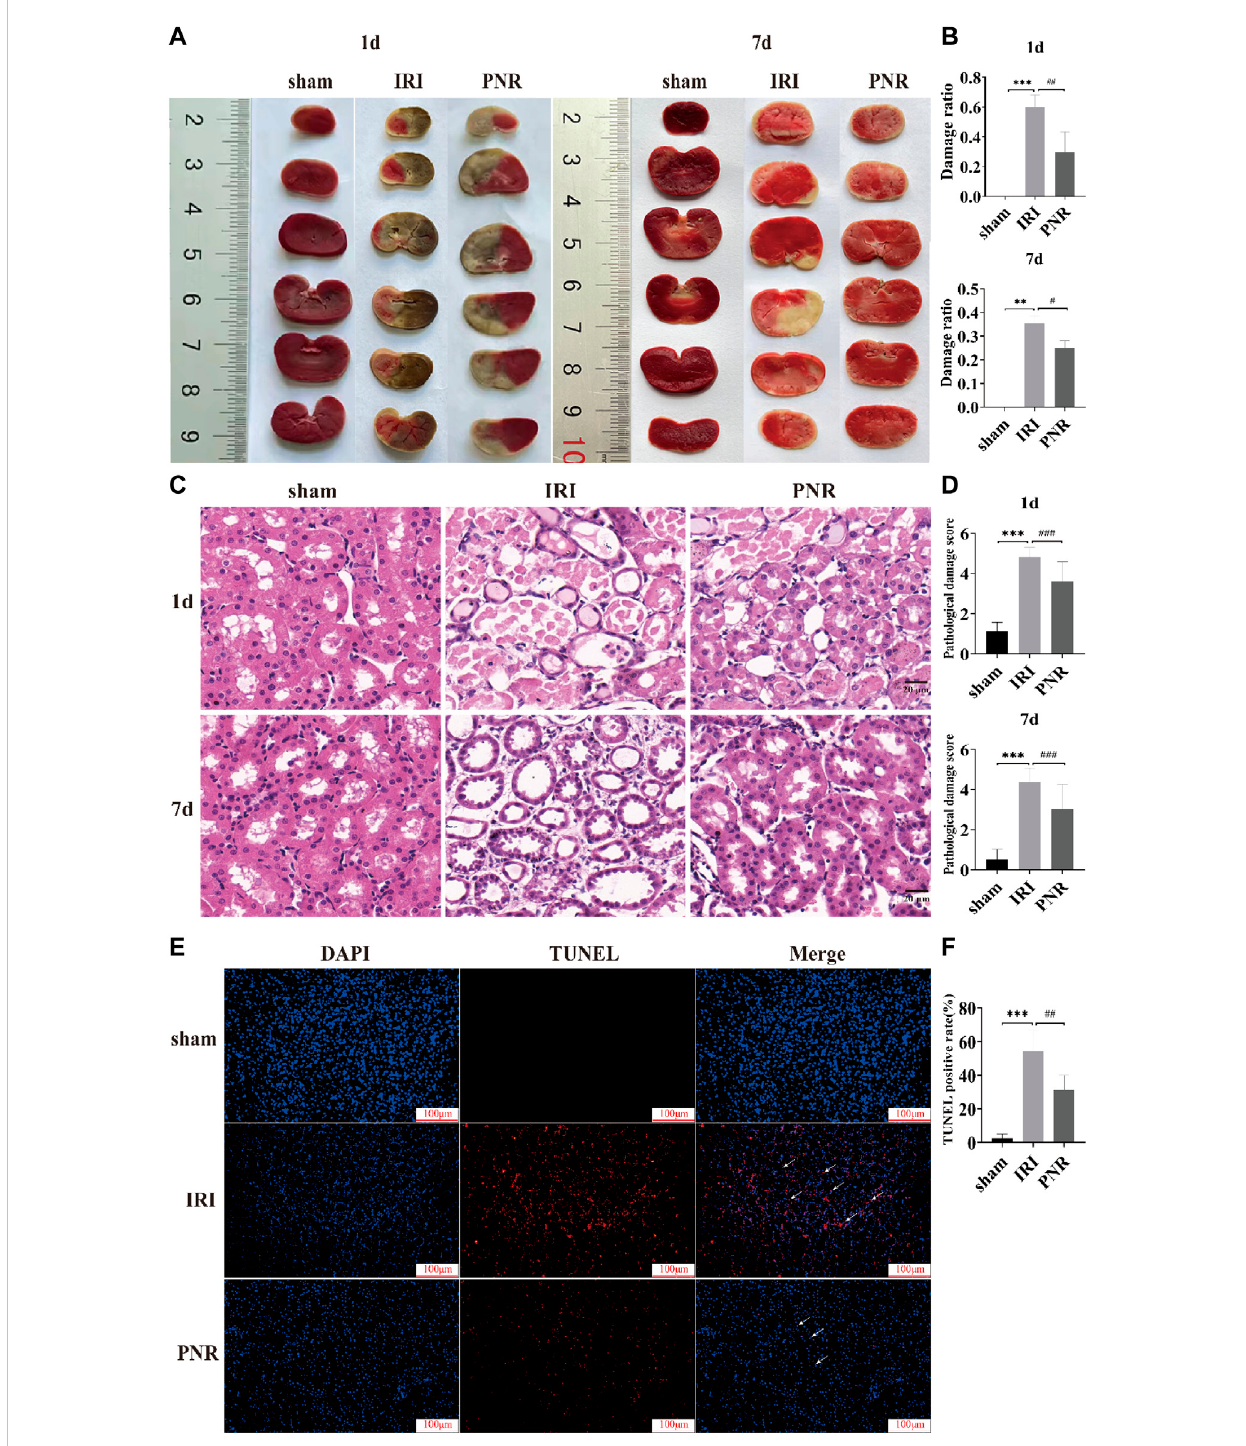
FIGURE 2 Results of histopathological damage to RIRI kidneys by pretreatment with the PNR. (A) TTC staining results of PNR pretreatment on each group at postoperativedays 1and 7; (B) statistical results oftheratio ofTTCstaining damage (N=3 – 4); (C) HE stainingresults ofPNR pretreatmentoneach group at postoperative days and 7 (×400 magni fi cation, scale bar = 20 μ m); (D) statistical results of HE staining pathological damage score (N = 3); (E) TUNEL staining results of PNR pretreatment on each group at postoperative day 7 (×200 magni fi cation, scale bar = 100 μ m); (F) statistical results of TUNEL staining-positive cells (N = 3). Compared with the sham group, *** p < 0.001, ** p < 0.01; compared with the IRI group, ### p < 0.001, ## p < 0.01, and # p <